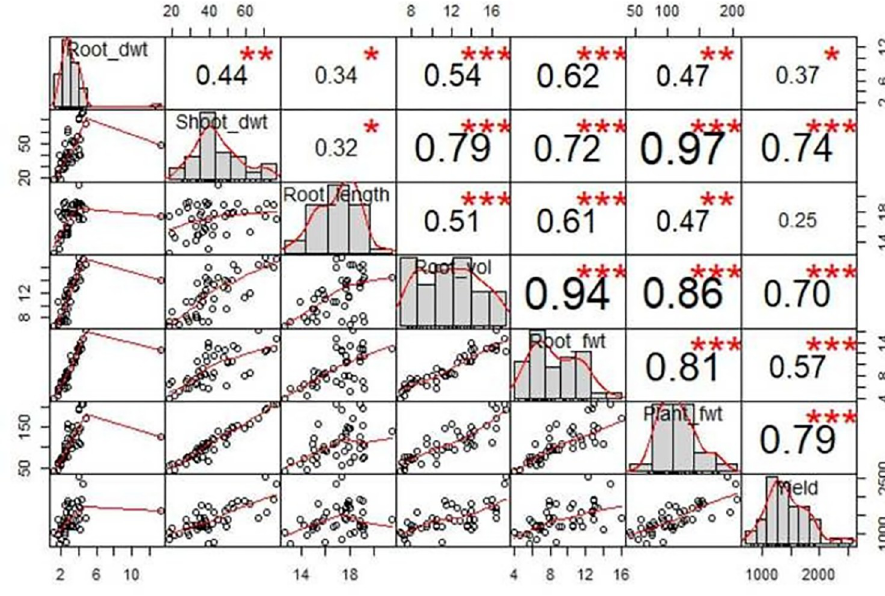
Fig 3. Correlation among root agronomic traits under low soil P conditions. NB: Root_dwt = root dry weight, shoot_dwt = shoot dry weight, root_vol = root volume, root_fwt = root fresh weight, plant_fwt = biomass yield.